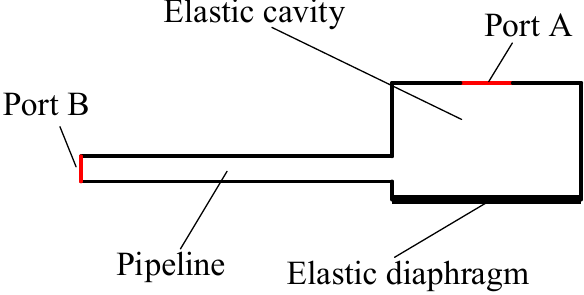
Figure 5. The two-dimensional simulation models.